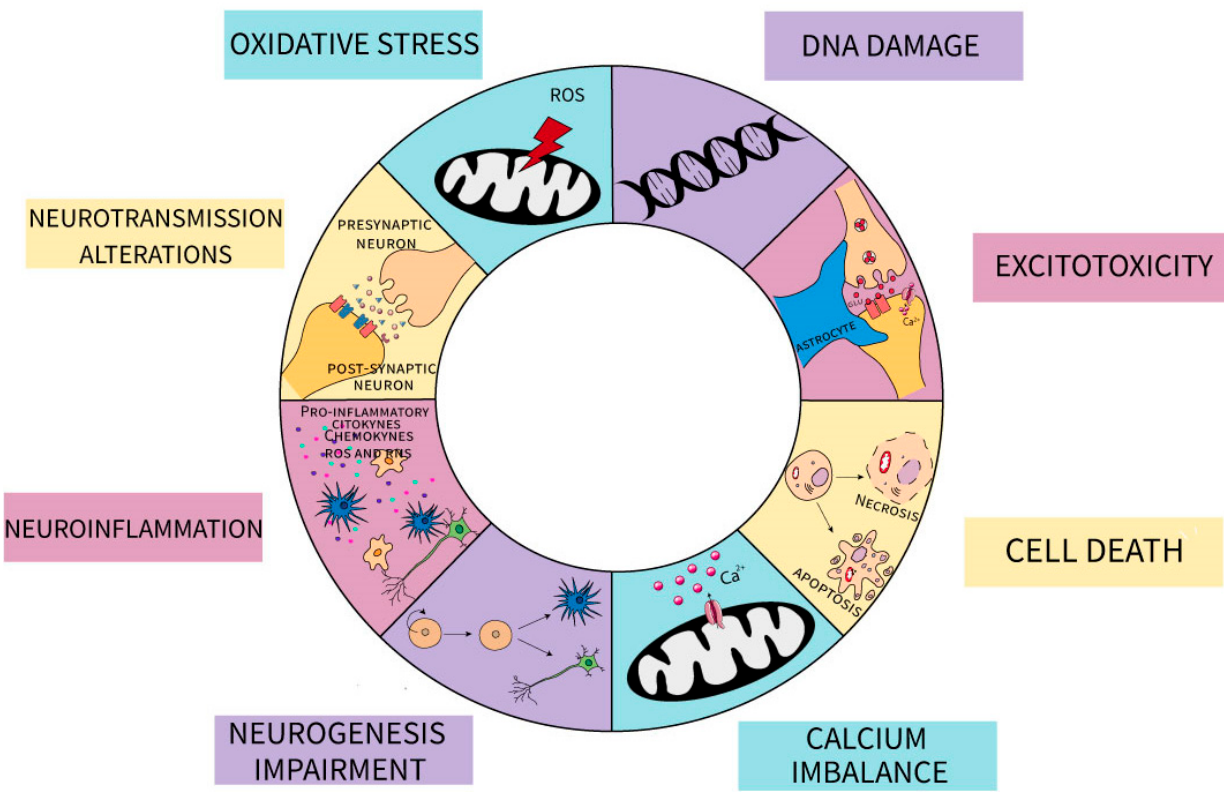
Figure 2. Schematic representation of the impact of MeHg on neuronal and glial cells. The different mechanisms are indicated: oxidative stress mediated by mitochondrial production of reactive oxygen species (ROS) and decrease in antioxidant defenses; DNA damage; excitotoxicity due to changes in both astrocytic and neuronal glutamate metabolism; cell death by apoptotic and necrotic pathways; Calcium imbalance characterize by an increase in [Ca 2+ ] cytoplasmatic; neurogenesis impairment both in neuronal and glial-committed lineages; exacerbation in neuroinflammation by an increase in proinflammatory mediators released by both glial and neuronal cells as cytokines, chemokines, ROS and reactive nitrogen species (RNS); changes in synaptic neurotransmission.